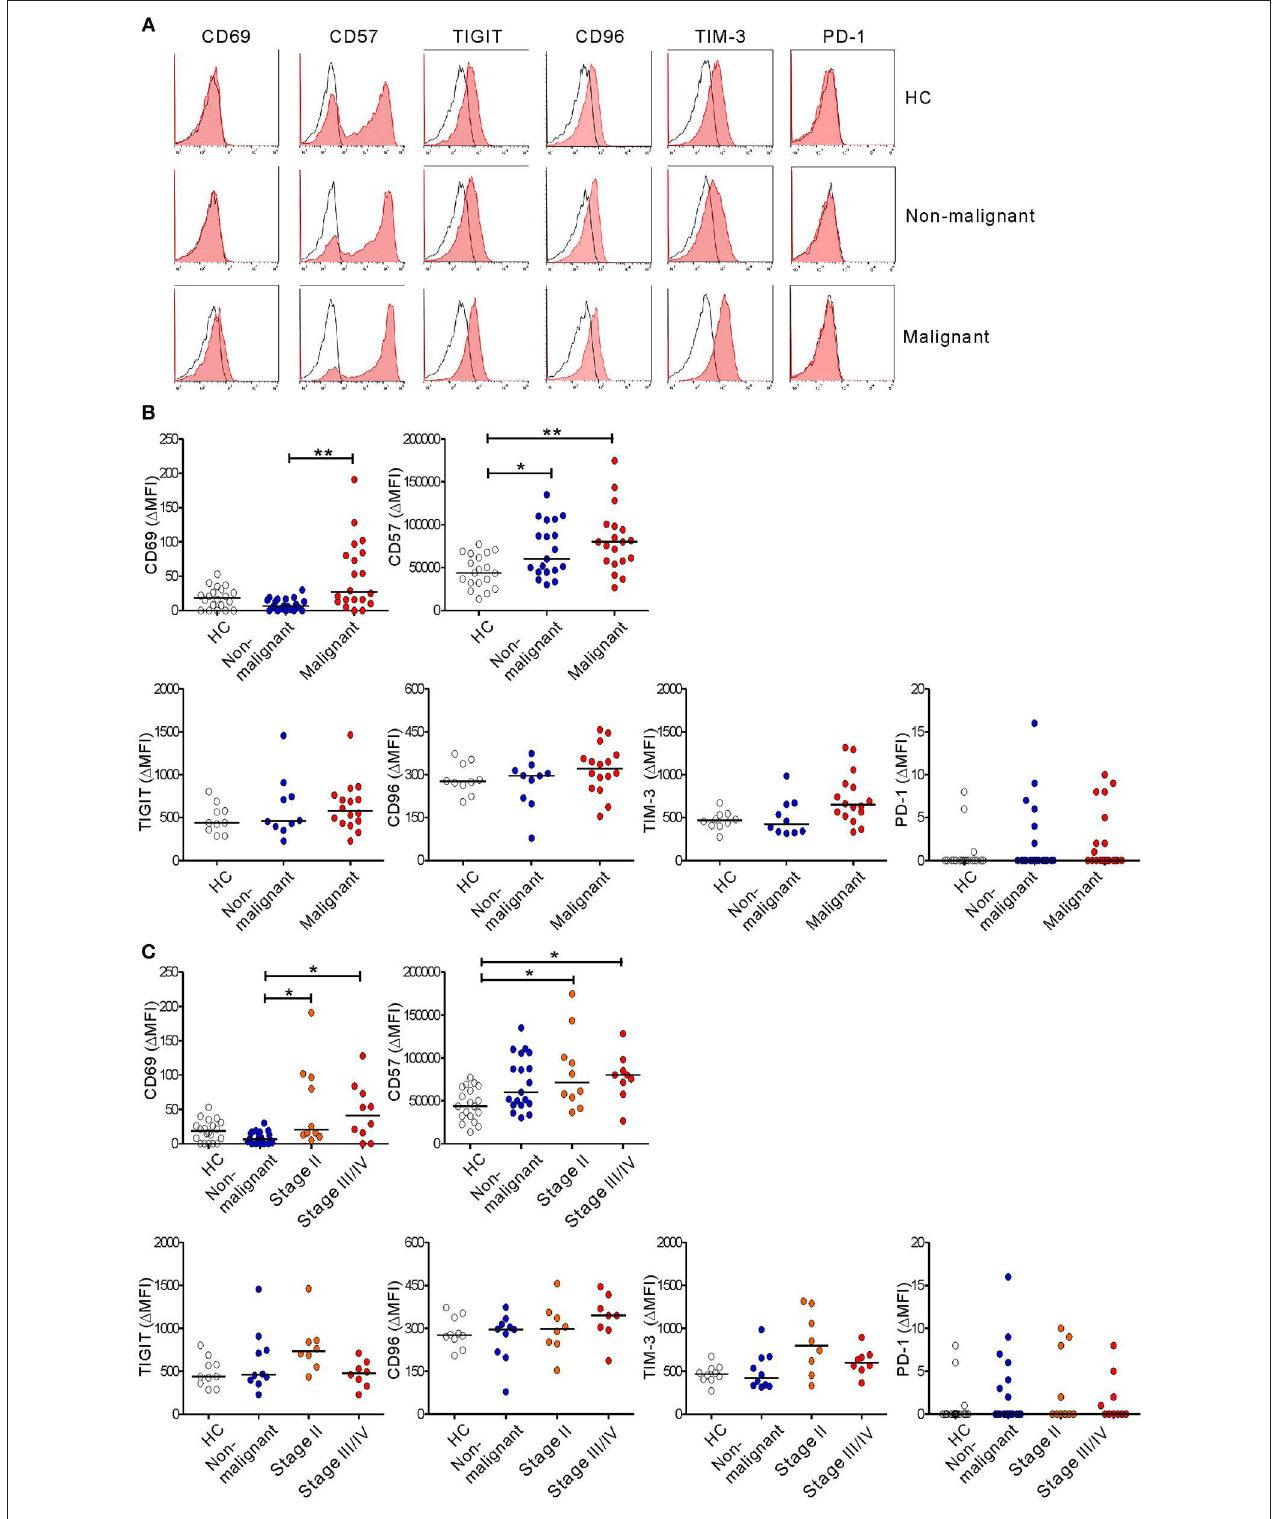
FIGURE 6 | Altered immunophenotype of NK cells from PC patients. (A) Representative FACS profiles showing the expression of CD69, CD57, TIGIT, CD96, TIM-3, and PD-1 (red shaded histograms) on gated NK cells in the healthy control (HC) group, the non-malignant group, and the malignant group. The solid lines indicate